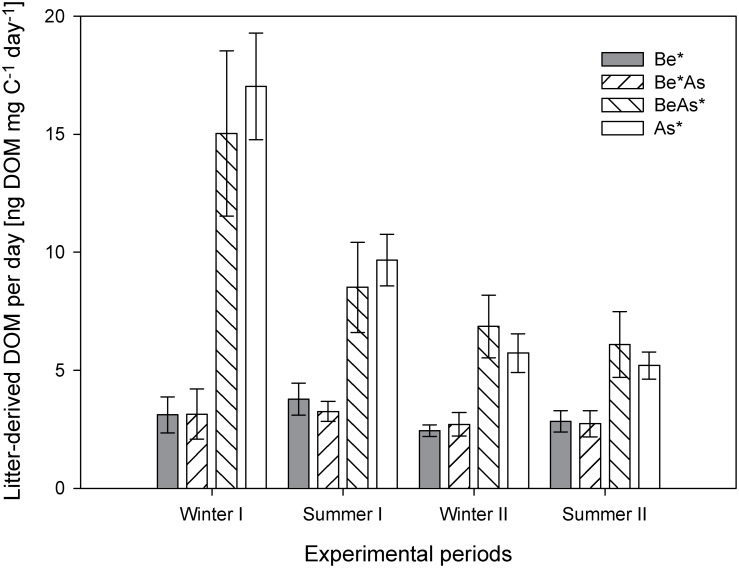
Calculated average daily release of litter-derived DOM (mean + standard error; n = 6) for the pure and mixed labeled (*) treatments of beech (Be) and ash (As) in the different winter (I: 16.12.08–30.03.09; II: 21.12.09–22.03.10) and summer periods (I: 20.04.09–30.11.09; II: 07.04.10–31.05.10).